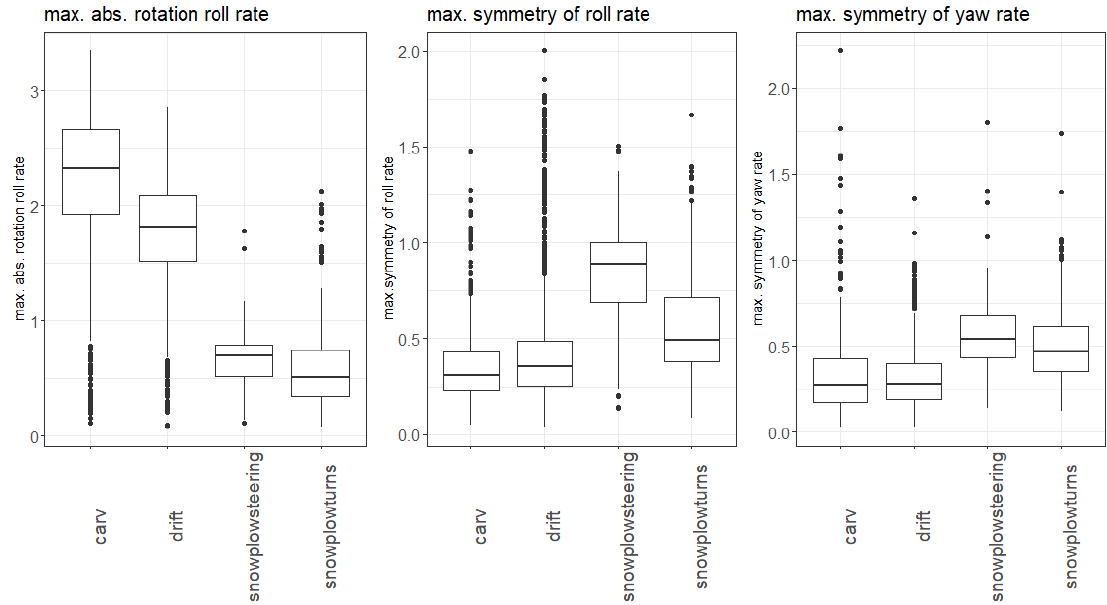
Figure 6. Features for the parallel / non-parallel distinction. The features are visualized via boxplots which show the summary statistics. The box represents the interquartile range (IQR = third quartile–first quartile), the thick line the median. The whiskers show the minimum and maximum values without outliers (1.5*IQR), the black dots the outliers which lie outside